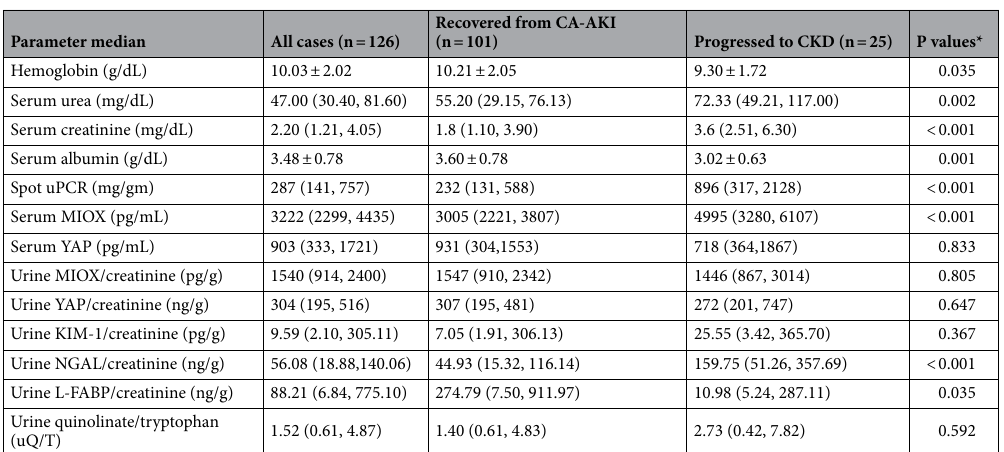
Table 2. Clinical characteristics, serum and urine biomarkers at the time of discharge in study subjects. Data presented as mean ± standard deviation and median (25th,75th, percentile). *p-value for comparison between patients recovered and progressed to CKD from CA-AKI. uPCR urine protein creatinine ratio, MIOX myo- inositol oxygenase, YAP Yes-associated protein, KIM-1 kidney injury molecule-1. NGAL neutrophil gelatinase- associated lipocalin, L-FABP liver-type fatty acid binding